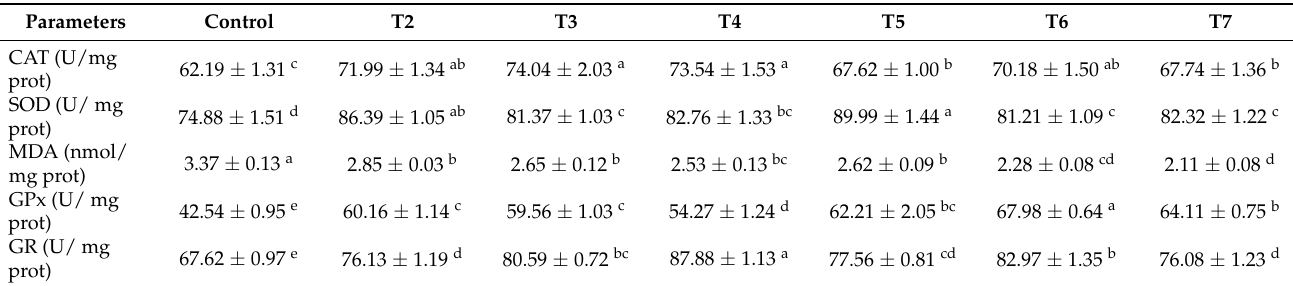
67.62 ± 0.97 e 76.13 ± 1.19 d 80.59 ± 0.72 bc 87.88 ± 1.13 a 77.56 ± 0.81 cd 82.97 ± 1.35 b 76.08 ± 1.23 d Data are expressed as the mean ± SE. Different letters (a–e) in the same row indicate significant differences among the treatments ( p < 0.05).